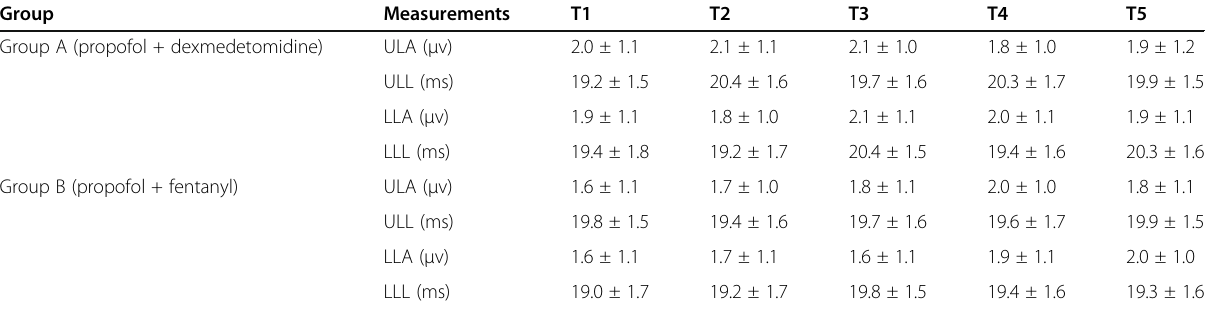
Table 2 Amplitude and latency of somatosensory-evoked potential at different time points (mean ± SD ) in groups A and B, p 0.37 Group Measurements T1